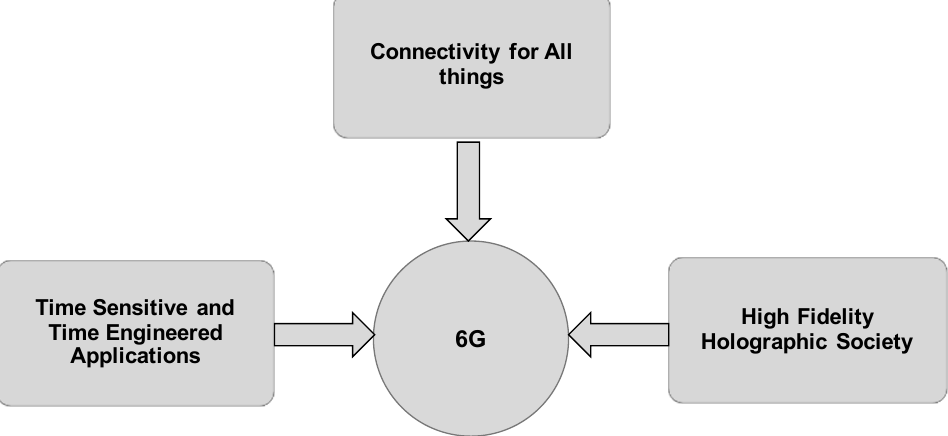
Figure 1. Key drivers for the 6th generation of wireless networks